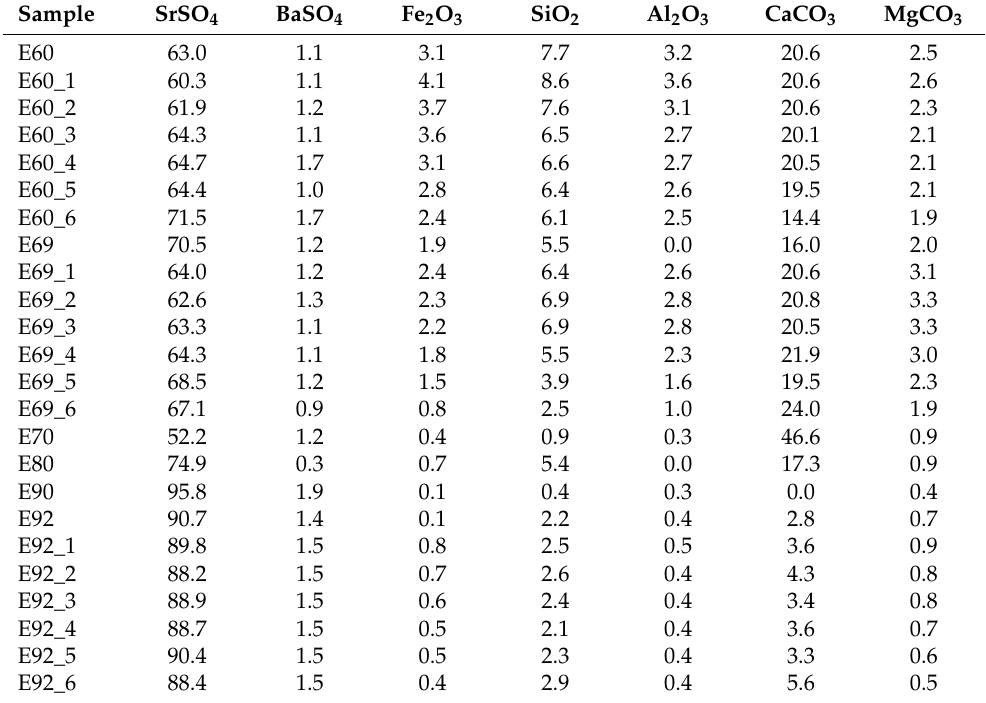
Table 2. Chemical composition of representative celestine mineral samples determined by XRF. Suf- fixes 1 to 6 correspond to fractions of same mineral sample with different particle sizes: 1 (0.1–0.3 mm),